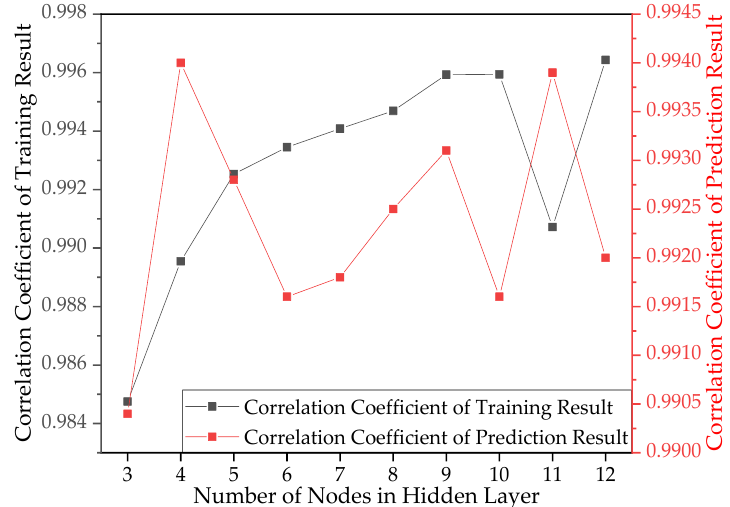
Figure 6. Correlation coefficients under different network structures.